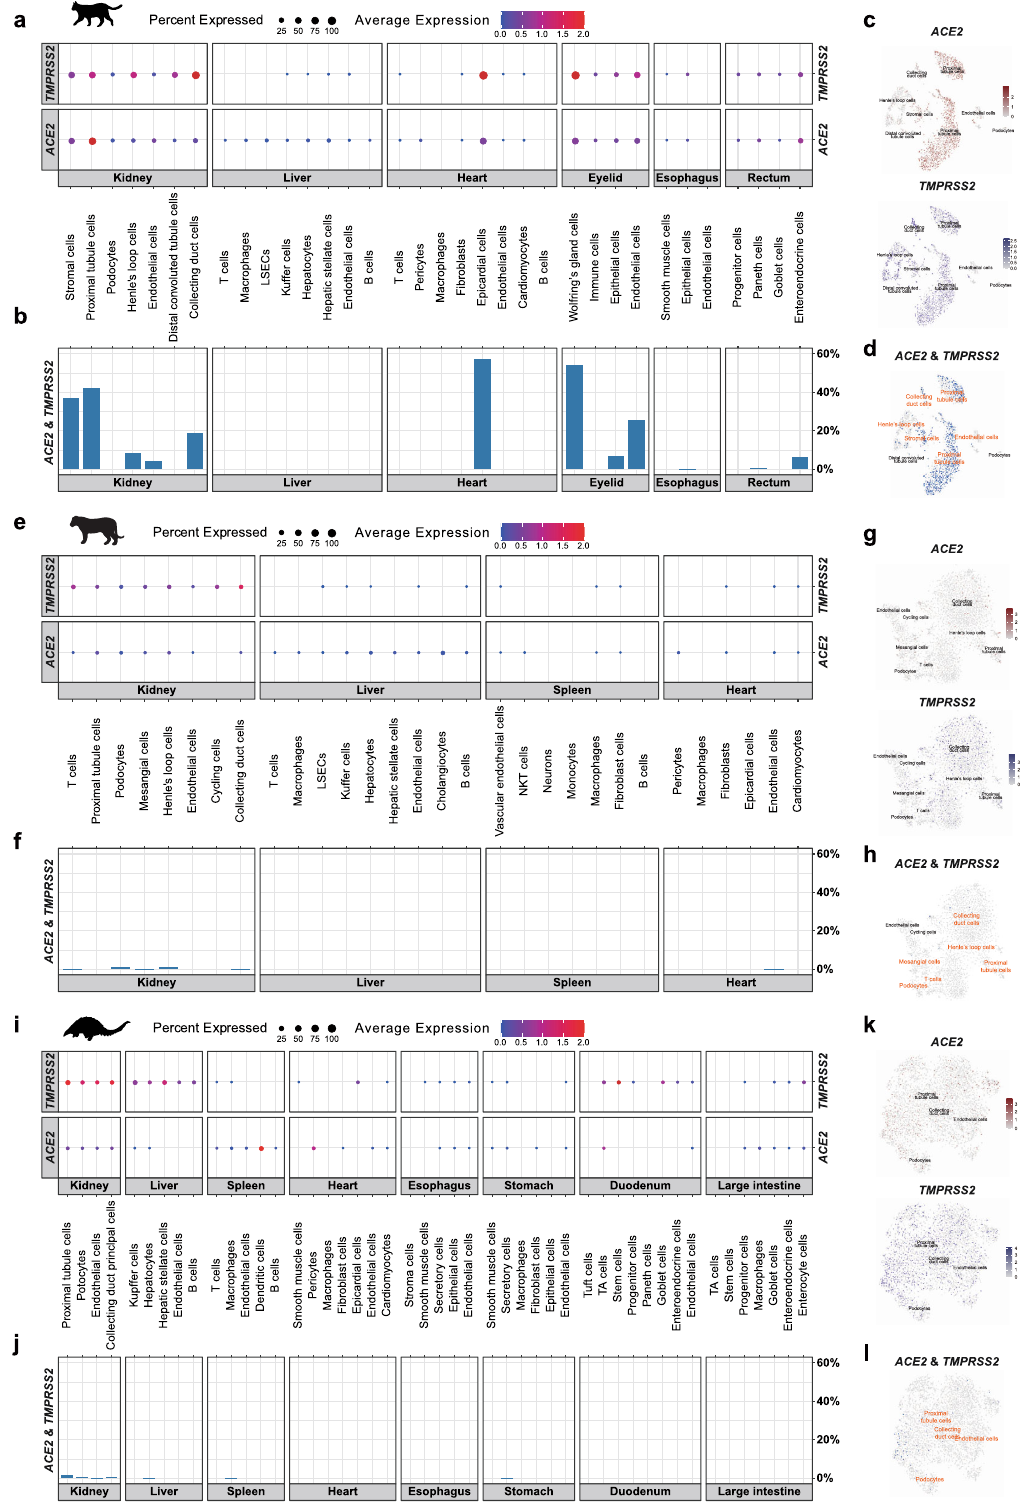
Fig. 2 Screening of putative SARS-CoV-2 target cells at single-cell resolution in various tissues of cat, tiger, and pangolin. a , e , i Dot plot showing the expression of ACE2 and TMPRSS2 in various cell types of cat ( a ), tiger ( e ), and pangolin ( i ). Each dot represents gene expression within indicated cell type, of which the color represents average normalized expression level and the size indicates the percentage of cells that expressed the gene within each cell type. b , f , j Bar plot showing percentage of cells that co-express ACE2 and TMPRSS2 within each cell type of cat ( b ), tiger ( f ), and pangolin ( j ). c , g , k Feature plot showing the expression pattern of ACE2 and TMPRSS2 , respectively, in indicated cell types in kidney of cat ( c ), tiger ( e ), and pangolin ( i ). d , h , l Feature plot showing the co-expression of ACE2 and TMPRSS2 in indicated cell types in kidney of cat ( d ), tiger ( h ), and pangolin ( l ). Putative SARS-CoV-2 target cells were highlighted with red-colored